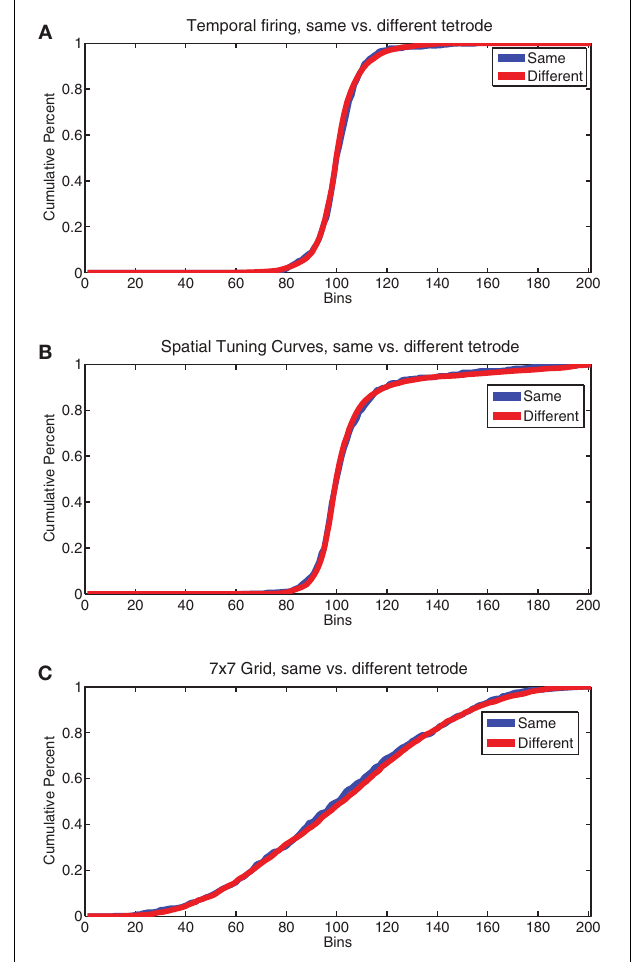
FIGURE 13 | Comparisons of cell firing patterns on the same vs different tetrodes. (A) Cumulative sum of the normalized histogram of the correlation coefficient of temporal firing rates for all pairs of cells recorded from the same tetrode (same) vs. all pairs of cells recorded from different tetrodes (different). (B) Cumulative sum of the normalized histogram of the correlation coefficient of spatial tuning curves for all pairs of cells recorded from the same tetrode (same) vs. all pairs of cells recorded from different tetrodes (different). (C) Cumulative sum of the normalized histogram of the correlation coefficient of all pairs of the 7 × 7 grids of FR seen in Figure 11 for all pairs of cells recorded from the same tetrode (same) vs. all pairs of cells recorded from different tetrodes